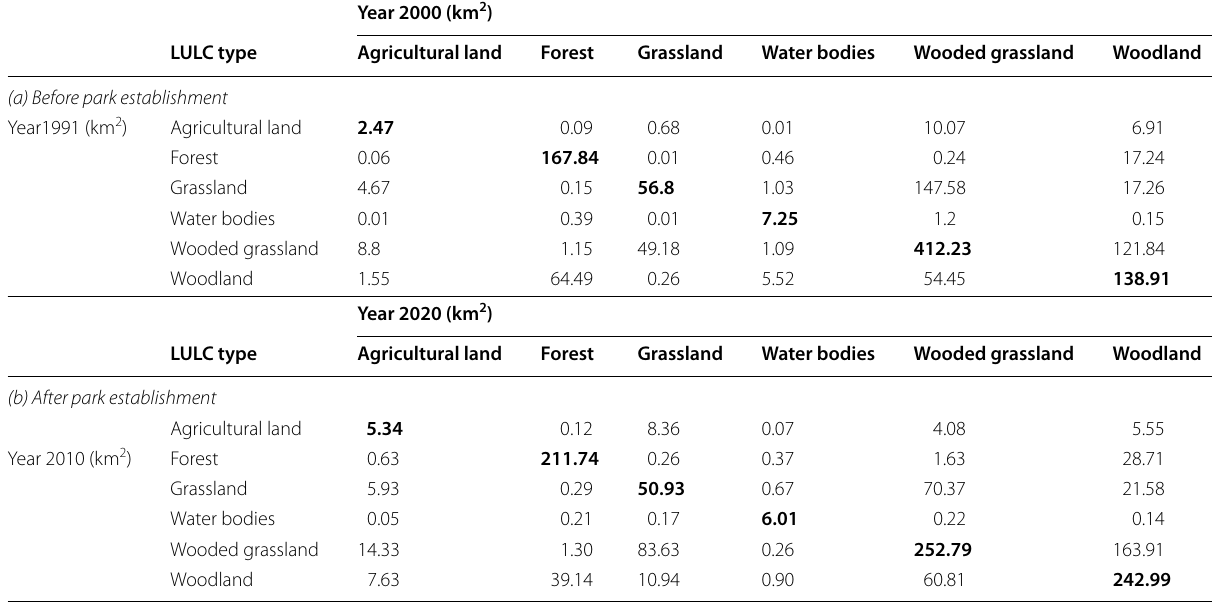
Table 3 Matrix of land use and land cover change (in km 2 ) within the current boundary of Chebera Churchura National Park (a) 1991 to 2000 (before establishment) and (b) 2010 to 2020 (after establishment) of the park. Values in bold font indicate stable land